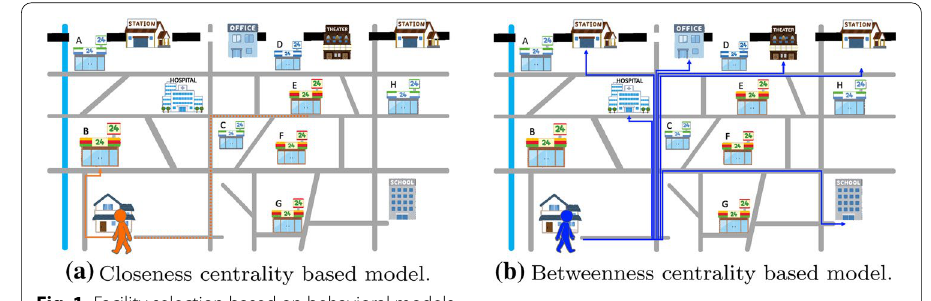
Fig. 1 Facility selection based on behavioral